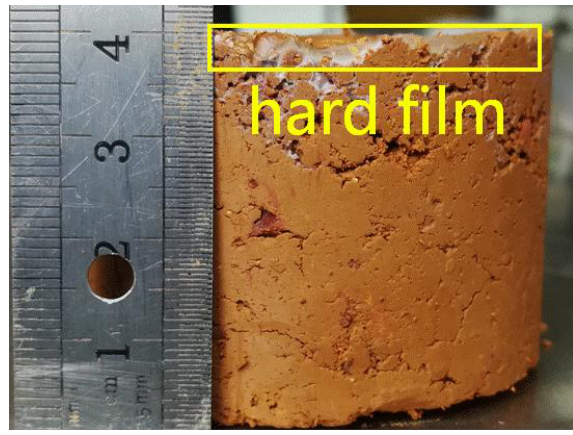
Figure 13. The hard film on the surface of a soil sample.